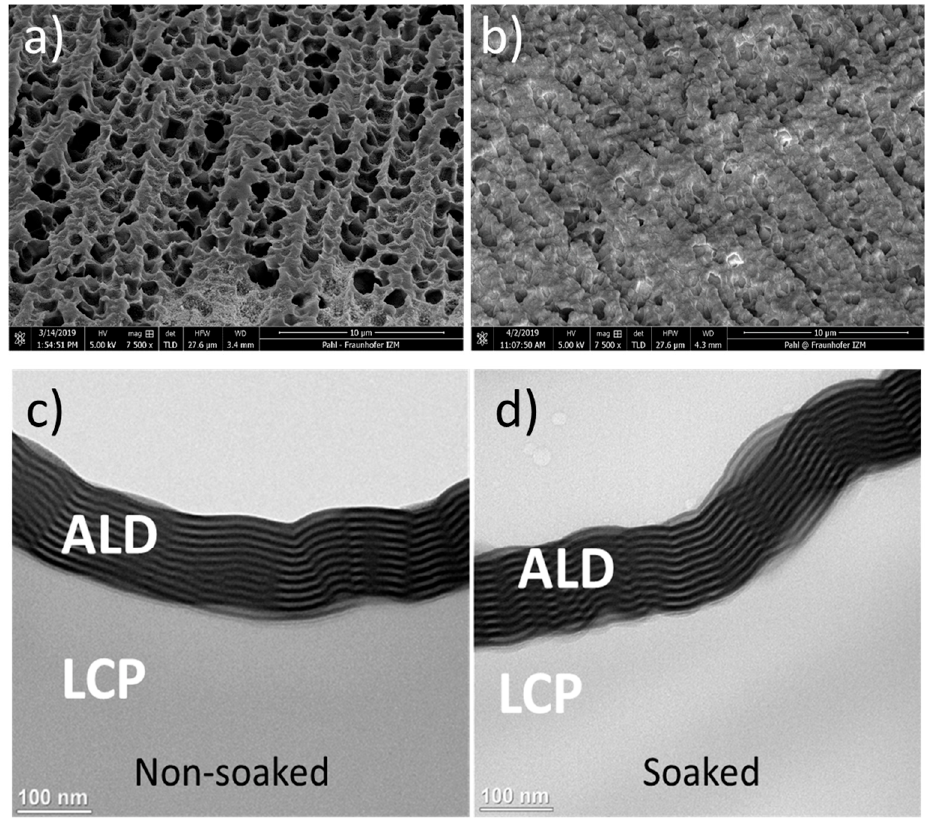
Figure 3. SEM images of bare LCP ( a ) and LCP coated with a 100 nm thick HfO 2 -based ALD ML (TFE1) ( b ). Cross-sectional TEM images of 100 nm HfO 2 -based ALD ML on LCP: ( c ) before soak; ( d ) after 2 months soak in PBS at 67 °C. Table 1. WVTR of the coatings measured with a Sorption Analyser at 60 ◦ C and 60% relative